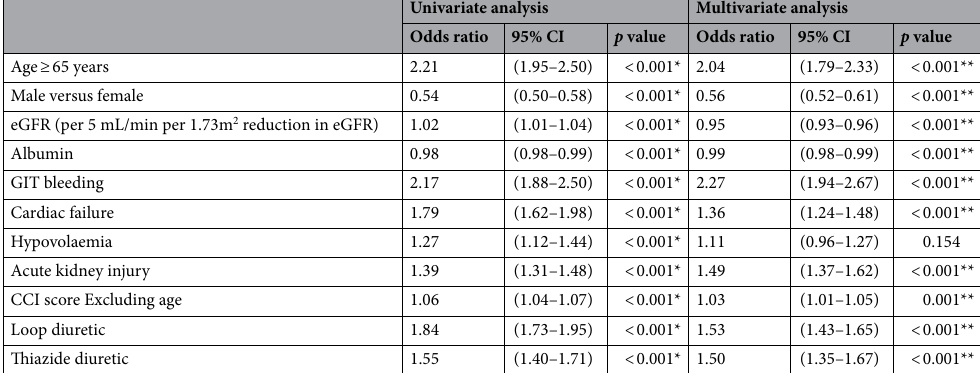
Table 2. Patient characteristics associated with elevated urea-to-creatinine ratio (UCR > 100). 95% CI 95% Confidence interval; eGFR Estimated glomerular filtration rate; GIT Gastrointestinal tract; CCI Charlson comorbidity index. * Patient characteristics with a p value < 0.01 in univariate analysis were selected for inclusion in multivariate analysis. ** p value < 0.05 in multivariate analysis was considered statistically significant.